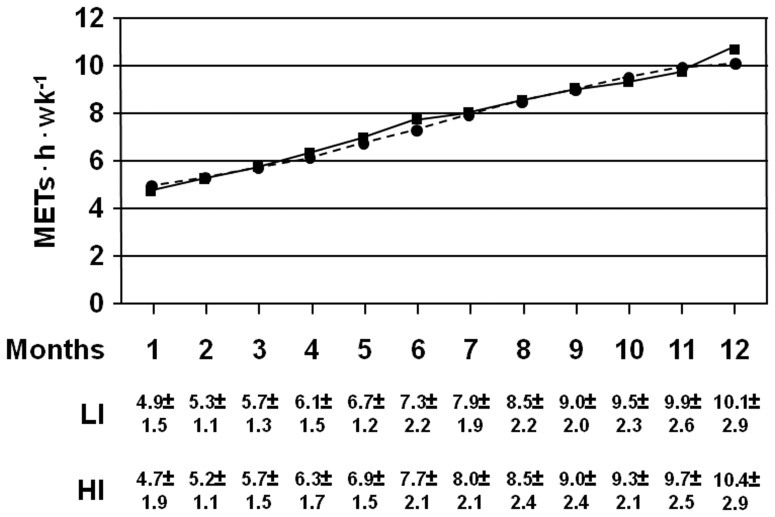
Average monthly energy expenditure from supervised exercise.Energy expenditure data in LI (circles, dotted line; n = 136) and HI (squares, continuous line; n = 152) participants [mean values; means (SD) are reported below]. LI = low intensity; HI = high intensity.